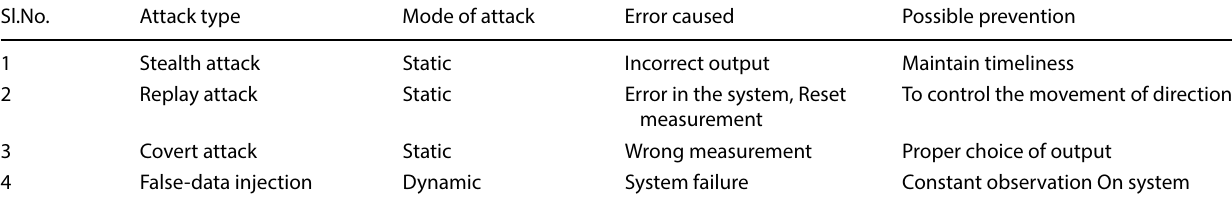
Table 2 Different mixer-unit and their corresponding mixing com- pletion time [33] Various kind module size and Bioassay operations